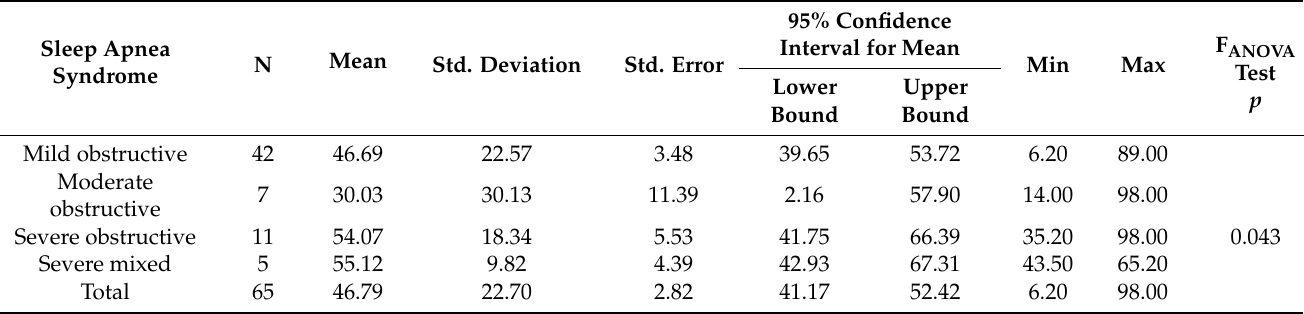
Figure 2. Distribution of the AHI/h ratio by types of SAS. Mean AHI/h +/ − SD (standard deviation) is higher in patients with severe sleep apnea syndrome as shown in Table 1. Table 1. Distribution of the AHI / h ratio by types of